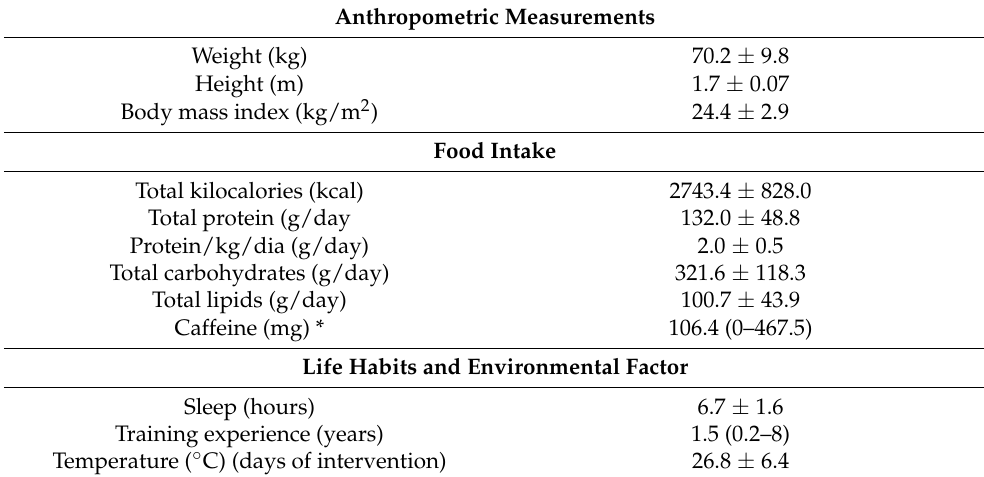
Table 1. Sample characterization and variables of interest.